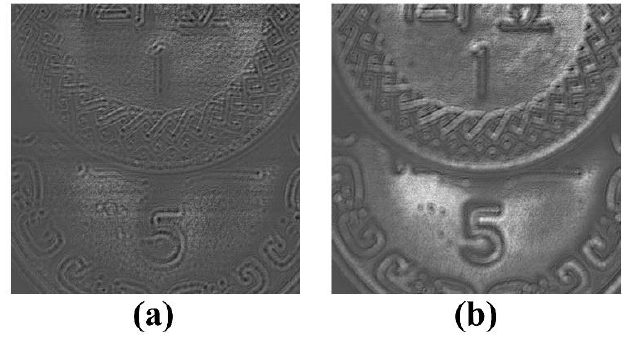
Figure 2. Hologram of two coins recorded by optical scanning holography (OSH): ( a ) real part, and ( b ) imaginary part. (Reproduced with permission from [57], OSA publishing, 2015). Appl. Sci. 2018 , 8 , 143